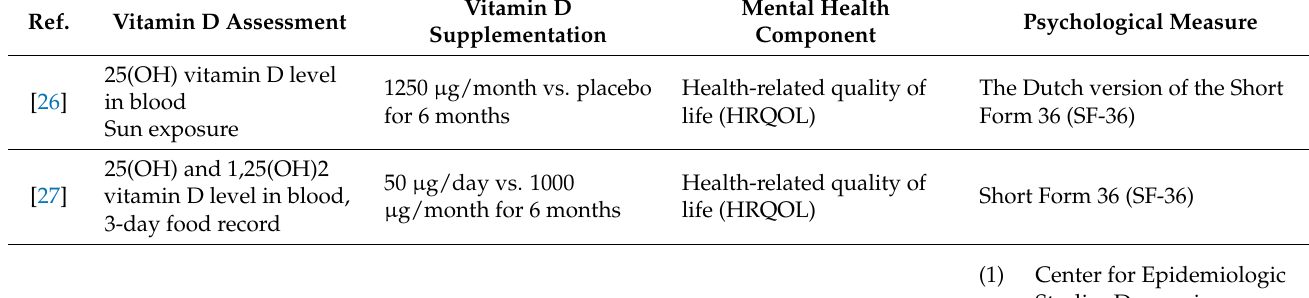
Table 4. The basic description of the exposure and outcomes within the studies included to the systematic review.